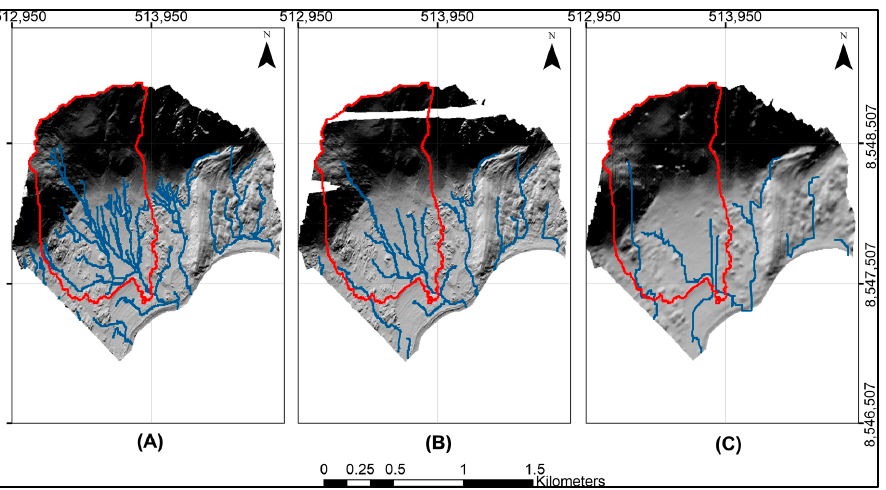
Figure 8. Delineated stream network in Fuglebekken catchment based on the three different DEMs: drone ( A ), SIOS ( B ), and ArcticDEM ( C ). The red polygon marks the catchment boundary.